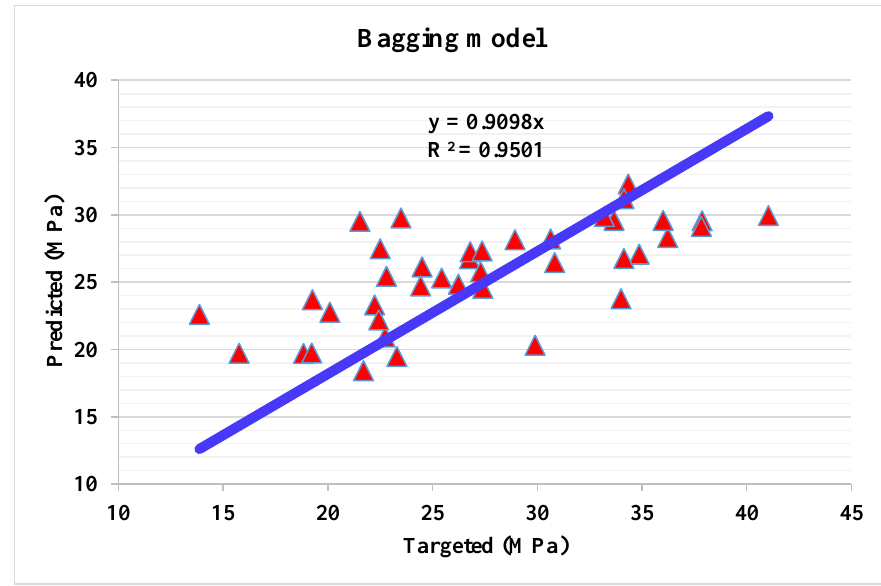
Figure 16. Predicted and actual results for bagging model.